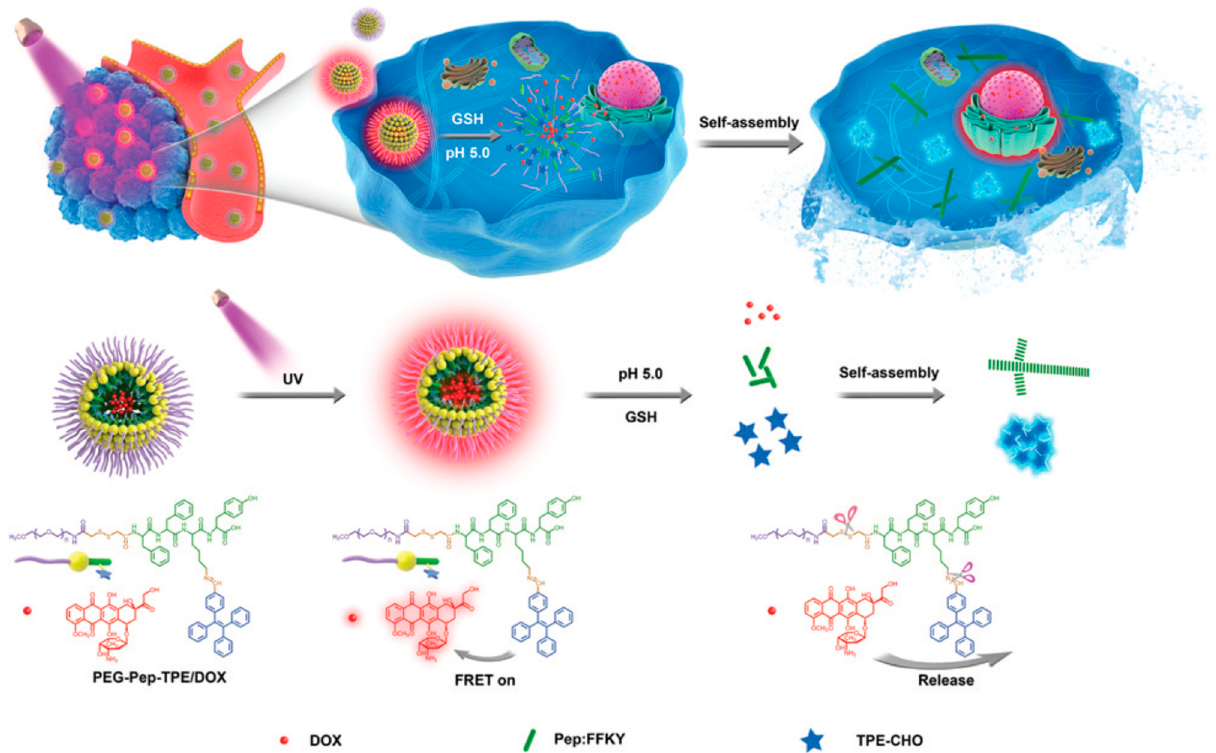
Figure 16. Schematic illustration of drug release behaviour from the self-assembled PEG-Pep-TPE/DOX NPs via FRET and pH/GSH-responsive antitumor synergistic chemotherapy. Reproduced with permission from ref. [48]. Copyright 2020, The Royal Society of Chemistry.